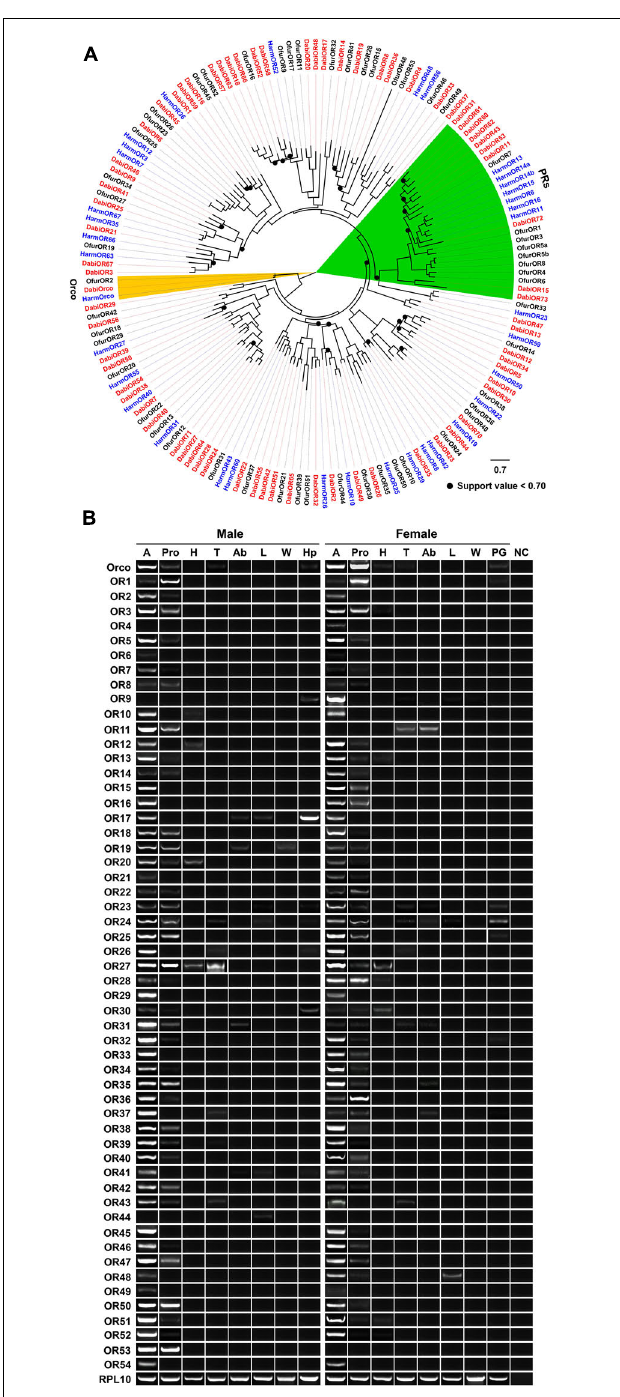
FIGURE 4 | The candidate OR gene family in D. abietella . (A) The phylogeny of ORs in H. armigera (Harm, blue), D. abietella (Dabi, red), and O. furnacalis (Ofur, black). For H. armigera ORs, we selected 35 representatives with known functional ligands. A candidate PR subfamily was highlighted and comprised 10 members in D. abietella . The tree was rooted with a conserved Orco lineage across insects. (B) Expression profiles of DabiORs in different tissues of both sexes from D. abietella . A reference gene, DabiRPL10 , was used to check the quality and quantity of cDNA templates. NC, negative control using sterile water as the template. The full names of tissues are listed in Table 1